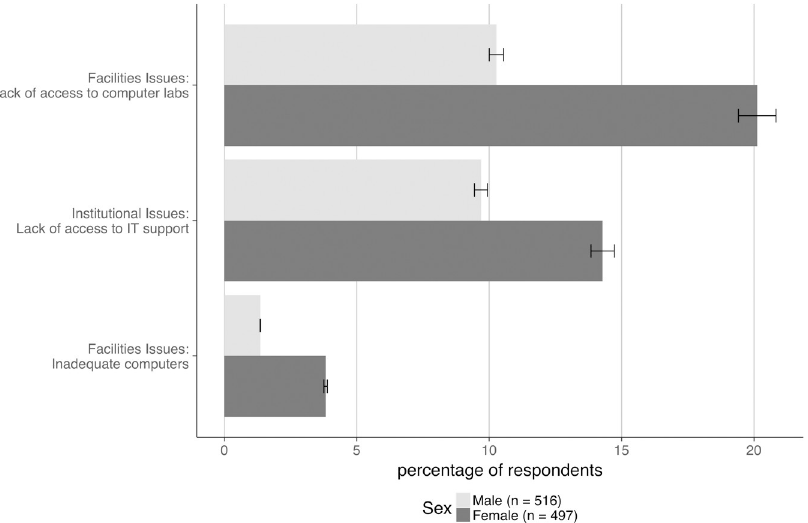
Fig 6. Barriers reported by females compared to males. Three barriers to integrating bioinformatics into instruction, all dealing with technology, were reported differently by males and females. As shown in the figure, females reported lack of access to computer labs, lack of information technology (IT) support, and inadequate computer resources at much higher rates than males.